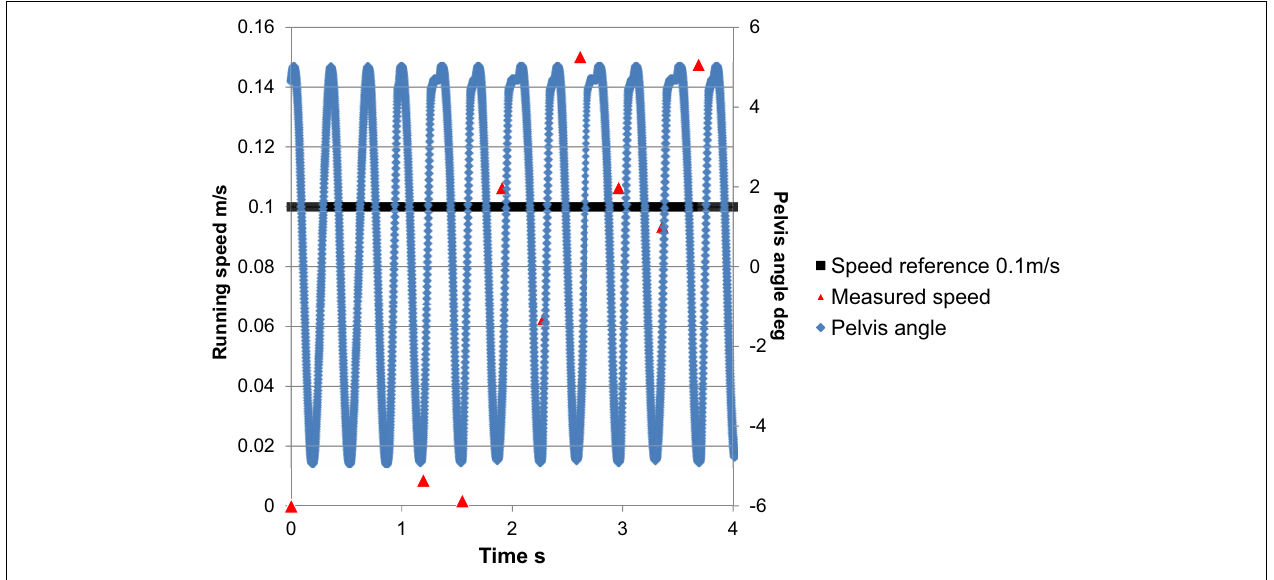
FIGURE 12 | Running speed transition . The robot successfully ran according to the reference running speed of approximately